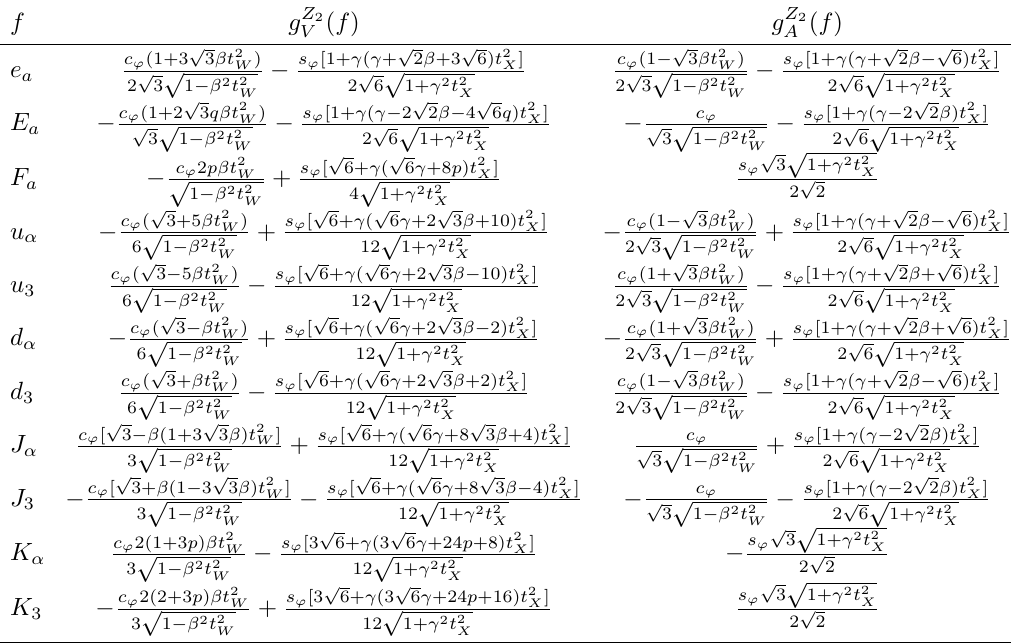
Table 6 . The couplings of Z